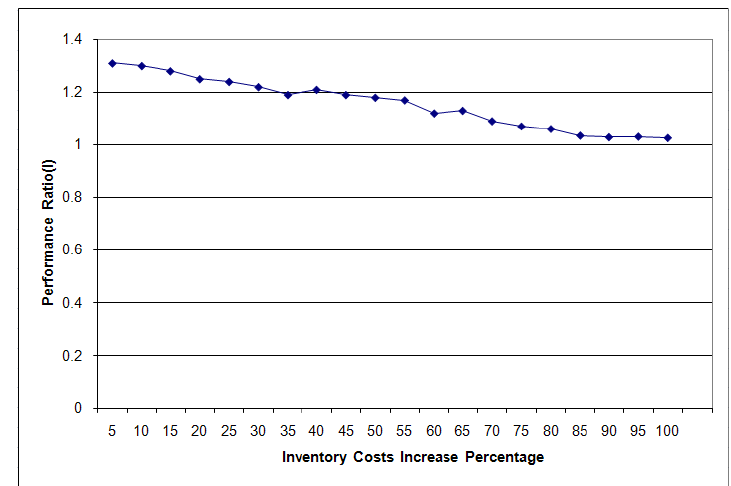
Figure 5: Performance ratio II as a function of increase in the inventory